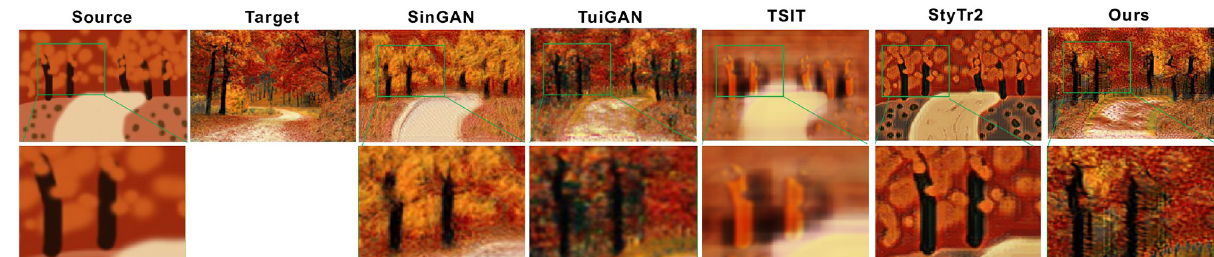
Fig 9. Results of painting-to-image translation. We amplify the green box in the translated image at the second row to show more detail.